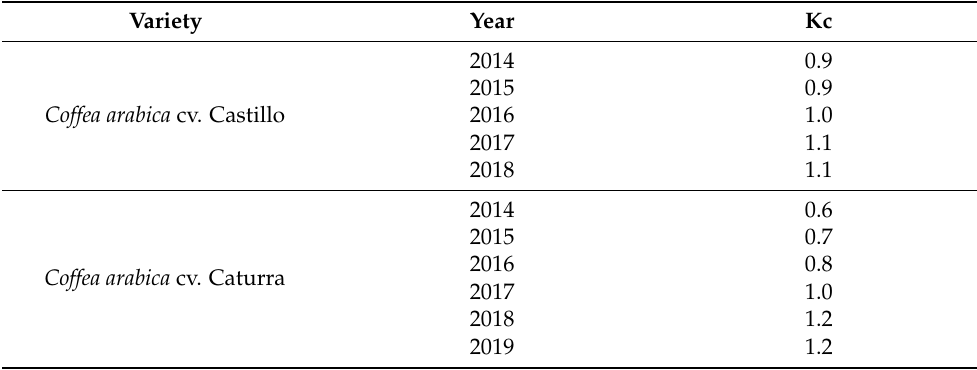
Table 3. Crop coefficients were used for both coffee trials during the study (adapted from Da Silva,